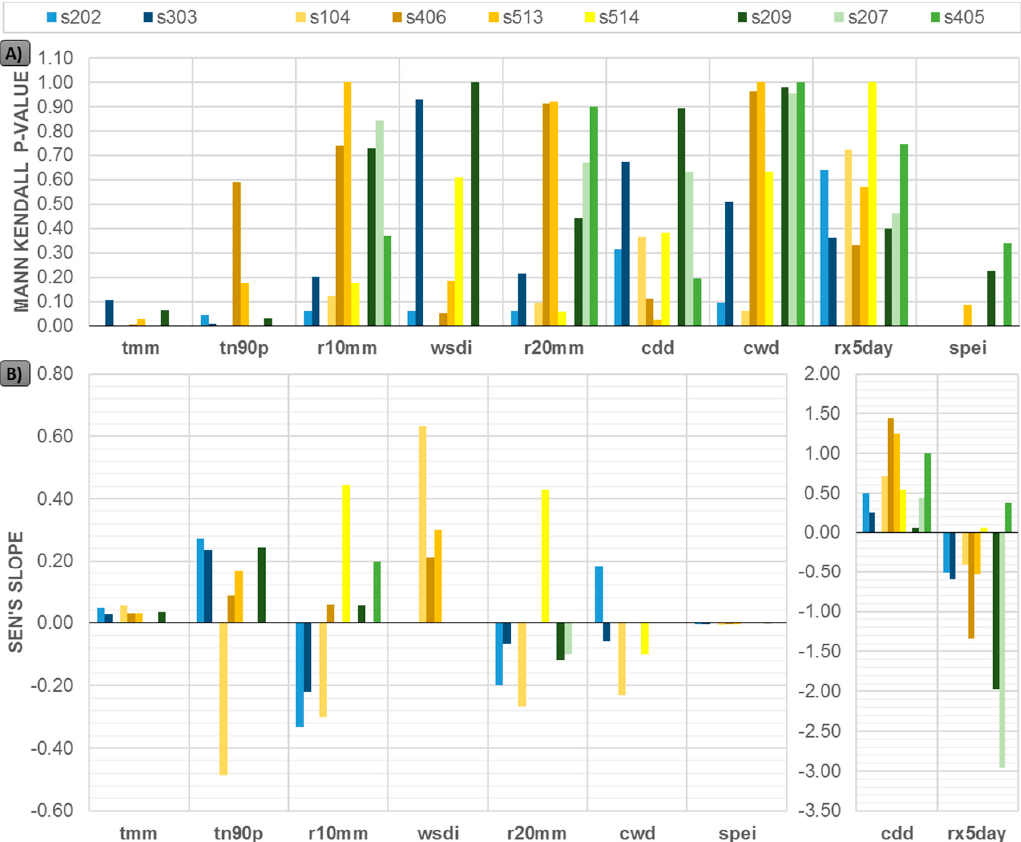
Figure 6. Historical (1980–2005) trends in nine selected ETCCDI indices across stations: two in mountain (blue), four in hill (yellow) and three in Tarai (green). ( A ) p -value for the Mann-Kendall test ( B ) Sen’s slope value for each of the indices.